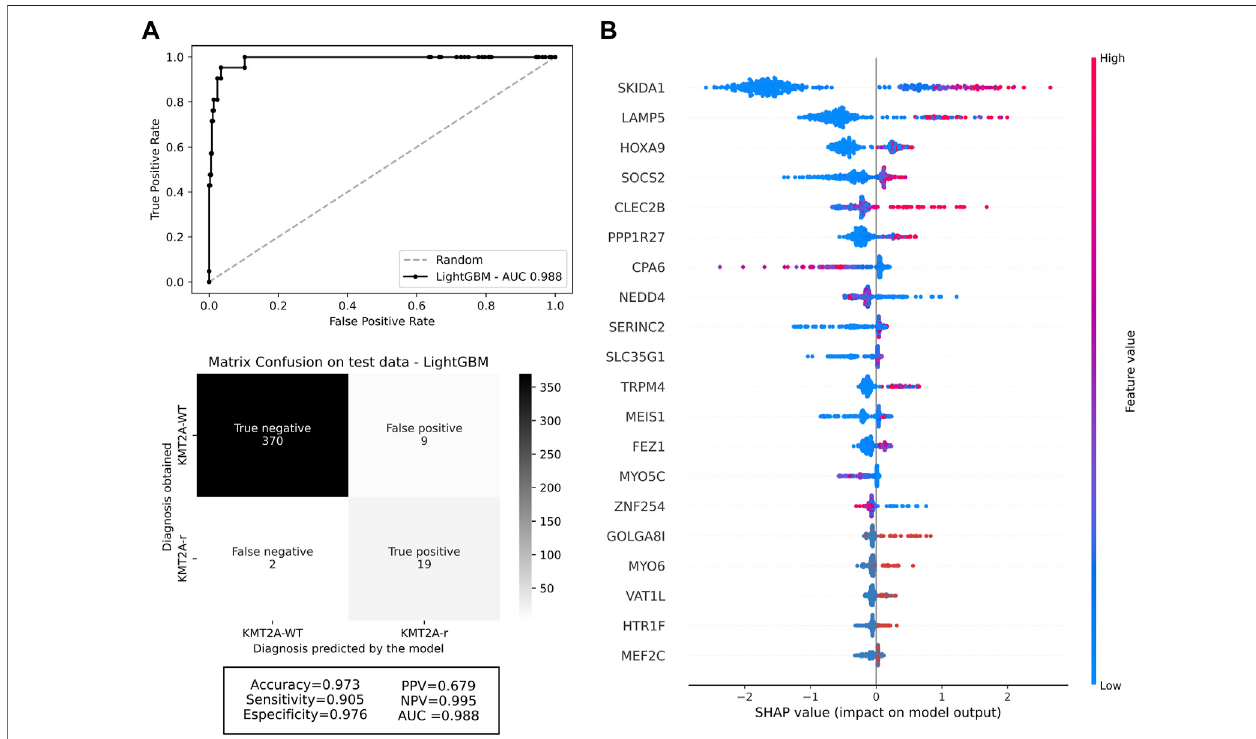
FIGURE 1 | Machine learning performance. (A) ROC curve of the selected machine learning model with 247 genes, and the confusion matrix with performance measures of testing data. The darker the quadrant color, the greater the number of patients. Respective performance measures are below the matrix. (B) Feature contributionsaccordingtothe shapley values. On the x -axis, positiveand negative valuesarecorrelatedwith prediction of KMT2A -r and KMT2A -WT, respectively. Each dot represents one patient, colored according to the feature value (red fading to blue means high to low values).